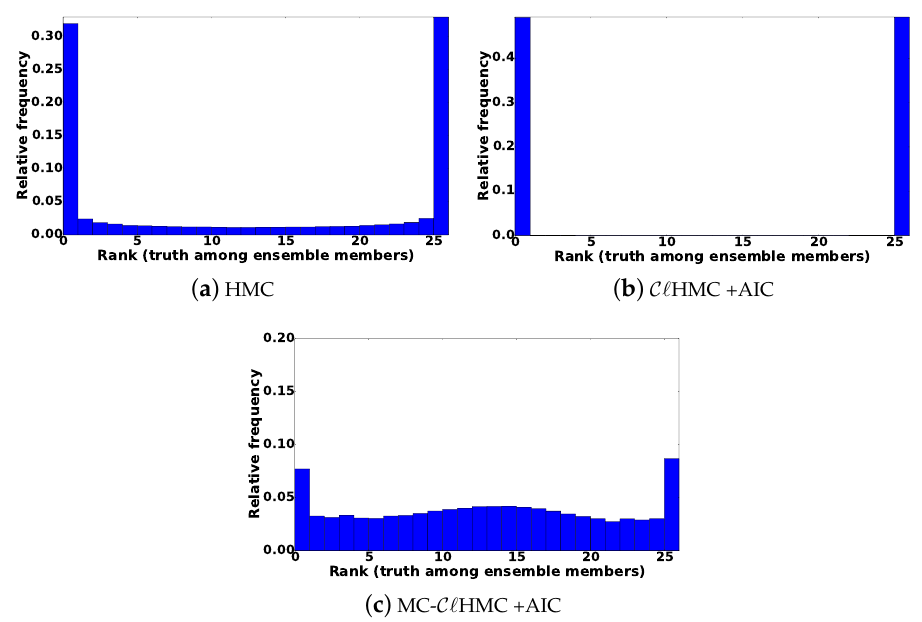
Figure 9. Data assimilation results using the nonlinear observation operator (30). The rank histograms of where the truth ranks among posterior ensemble members. The ranks are evaluated for every 16th variable in the state vector (past the correlation bound) at 100 assimilation times. The filtering scheme used is indicated under each